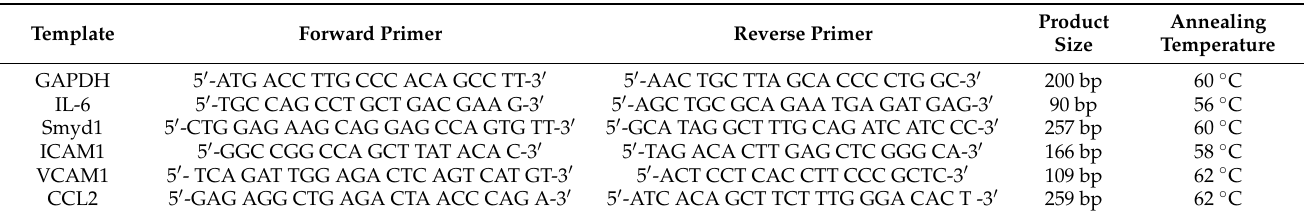
Table 1. Primer sequences, product sizes and annealing temperatures used to amplify the corresponding cDNA templates. Template Forward Primer Reverse Primer